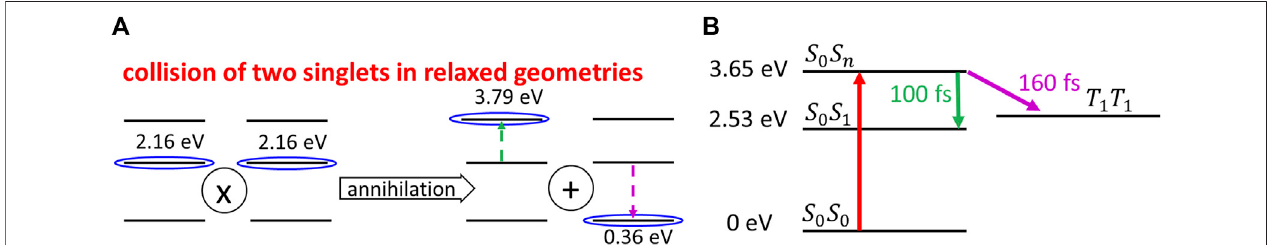
FIGURE6|(A) Schemeofthesinglet – singletannihilationprocess,whichcanbedescribedasasimultaneousvirtualESA(indicatedbythegreendashedarrow)and thevirtualluminescence(shownbythevioletdashedarrow). (B) Internalconversiontothe S 1 statebytheKashaprocessduringca100 fsaftertheexcitationtothehigher